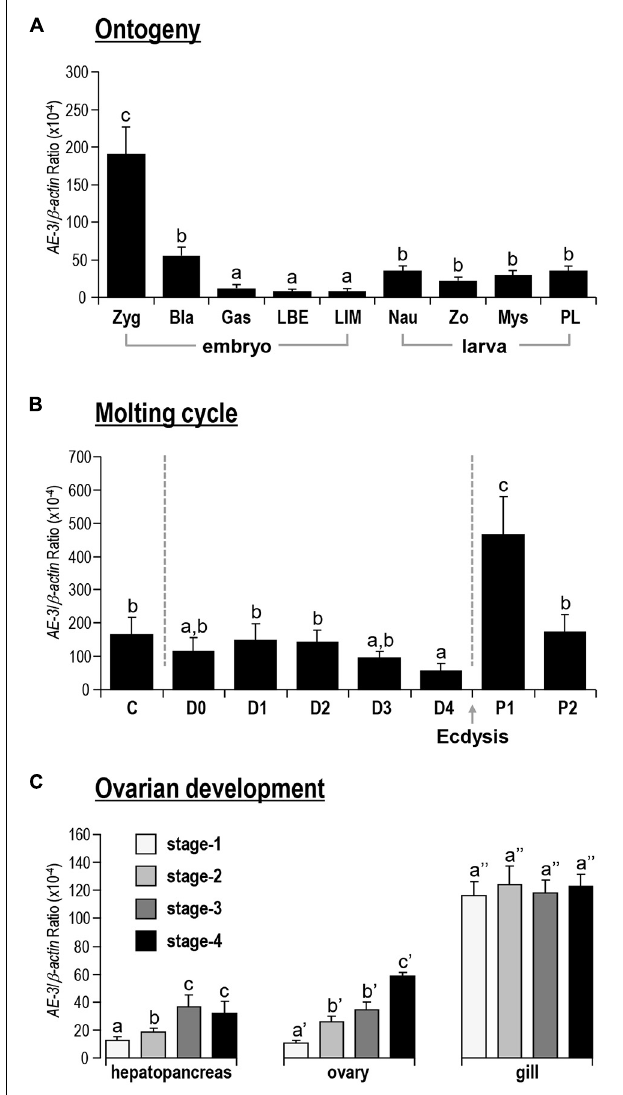
FIGURE 5 | (A) Ontogeny of Lv-AE3 mRNA. The selected embryonic and larval developmental stages included the zygote (Zyg), blastula (Bla), gastrula (Gas), limb bud embryo (LBE), larva in membrane (LIM), nauplius (Nau), zoea (Zo), mysis (Mys), and postlarval (PL) stages. (B) Lv-AE3 mRNA expression in the gill during the molt cycle. The molt cycle is classified as an intermolt stage (C), five premolt stages (D0, D1, D2, D3, and D4), and two postmolt stages (P1 and P2). (C) Lv-AE3 mRNA expression in the hepatopancreas, ovary and gill during ovarian development from stages I to IV. For ontogeny, molting and ovarian development, the data presented are expressed as the mean ± SE ( n = 5), and the groups denoted by the same letter represent a similar expression level ( P > 0.05, two-way ANOVA followed by Fisher’s LSD test).